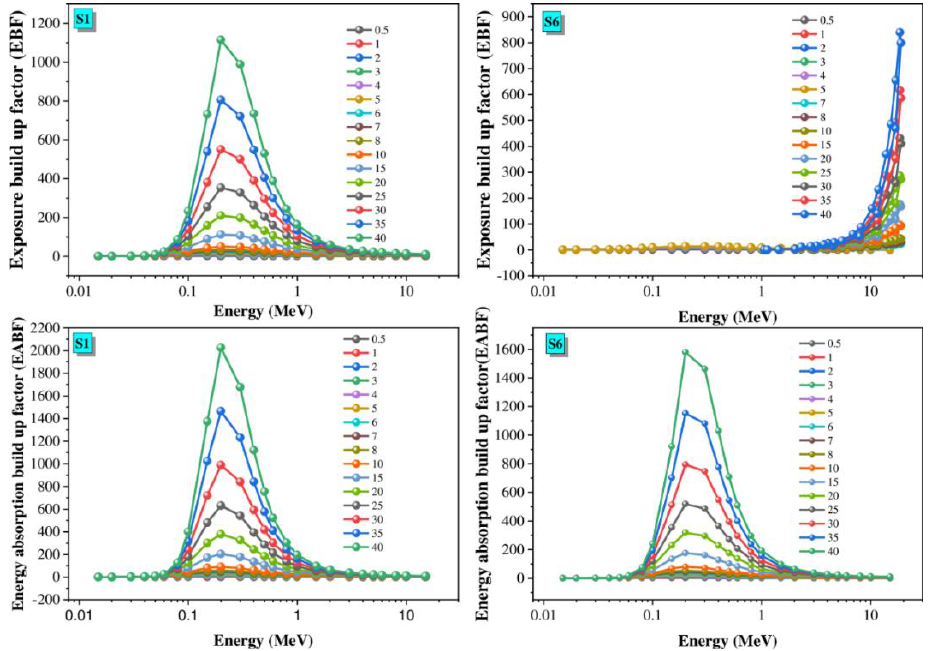
Figure 13. Dependence of EBF and EABF on the radiation energy.